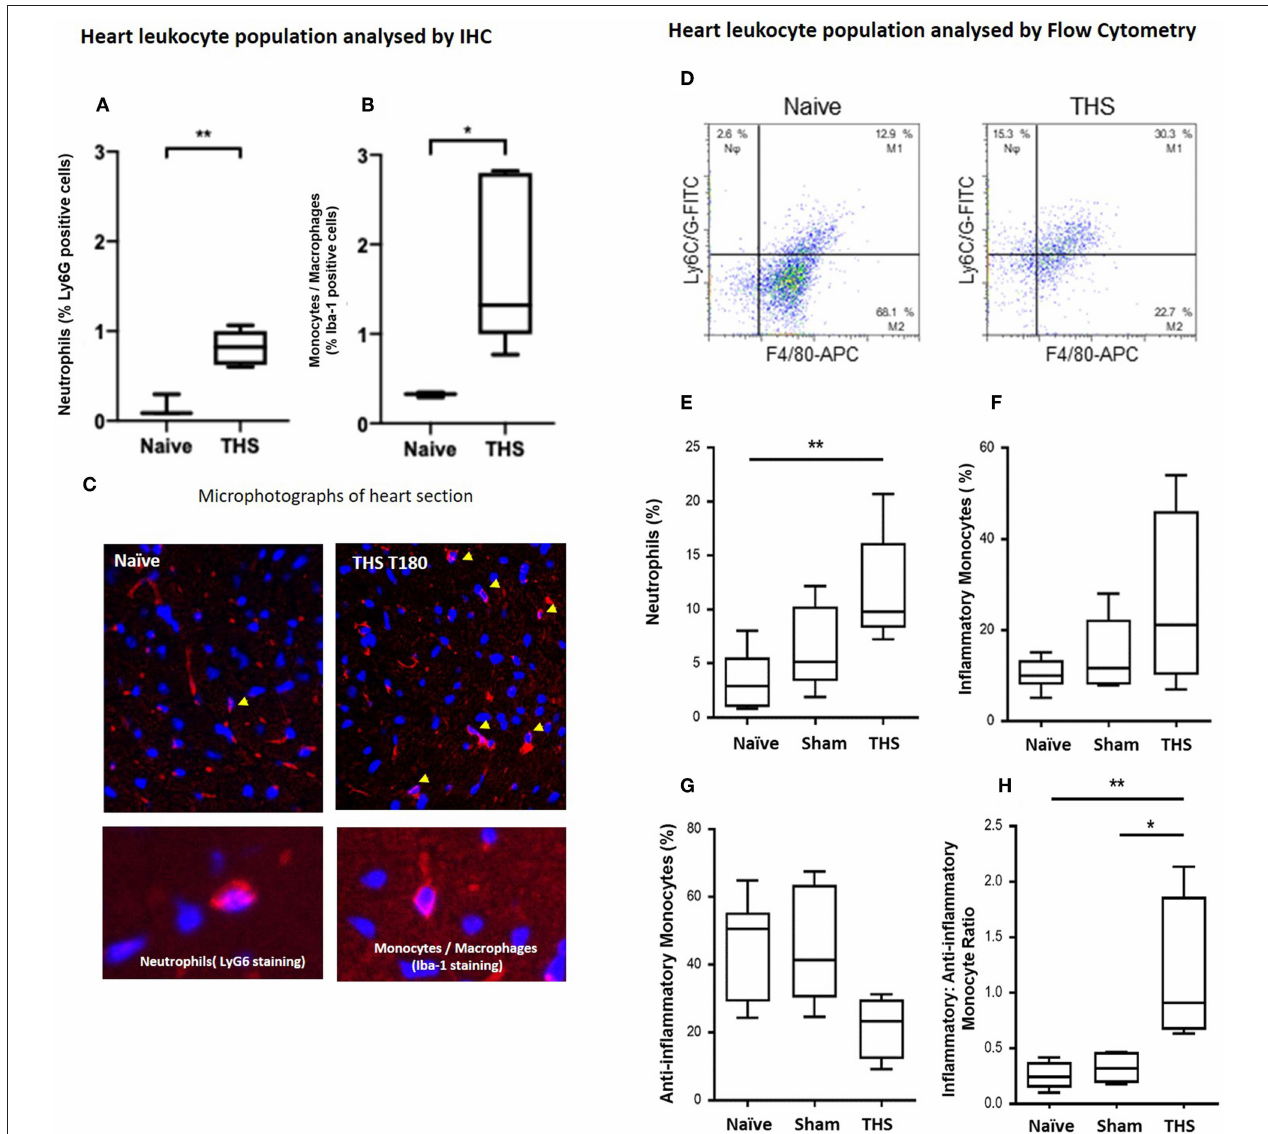
FIGURE 3 | Characterization of acute cardiac inflammation response in the Trauma Hemorrhage induced CD murine model (THS). Immunohistochemistry (IHC) myocardial analysis shows (A) a significant increase in neutrophils (% Ly6G cells) and (B) Monocytes/Macrophages (% Iba-1 cells) in the THS model (T180min) compared to naïve (** p < 0.001, * p = 0.02; two-tailed unpaired t -test). Data is presented as means ± SD. (C) Representative IHC microphotographs in heart section in a THA and naïve animal (x400) and zoom insets of the LY6G and Iba-1 staining (red) for the neutrophils and monocyte/macrophage, respectively, with the nuclei Hoechst staining (blue) in a THS model. (D–H) Flow cytometry assessment of heart-infiltrating leukocytes. (D) Representative forward scatter/side scatter profile and a live cell gate. Following a CD45/side scatter plot to obtain the CD45 + leukocyte2, Ly6G Hi, or low expression with F4/80 plots was used to derived percentages of pro-inflammatory monocytes (Ly6GHi, F4/80 + : M1 phenotype) and anti-inflammatory monocytes/macrophages (Ly6GLow, F4/80 + : M2 phenotype). The heart from THS animals showed a significant increase in the M1:M2 phenotype ratio, compared to the naïve animals. (E) A significant presence of neutrophils (% Ly6G + F4/80- cells) and a high ratio of inflammatory monocytes ( F–H ; Higher ratio of Ly6GHi, F4/80 + inflammatory monocytes vs. F4/80 + : M2 anti-inflammatory macrophages/monocytes; ** p < 0.001, * p = 0.02; one-way ANOVA with post-hoc analysis). Data all presented as means ±